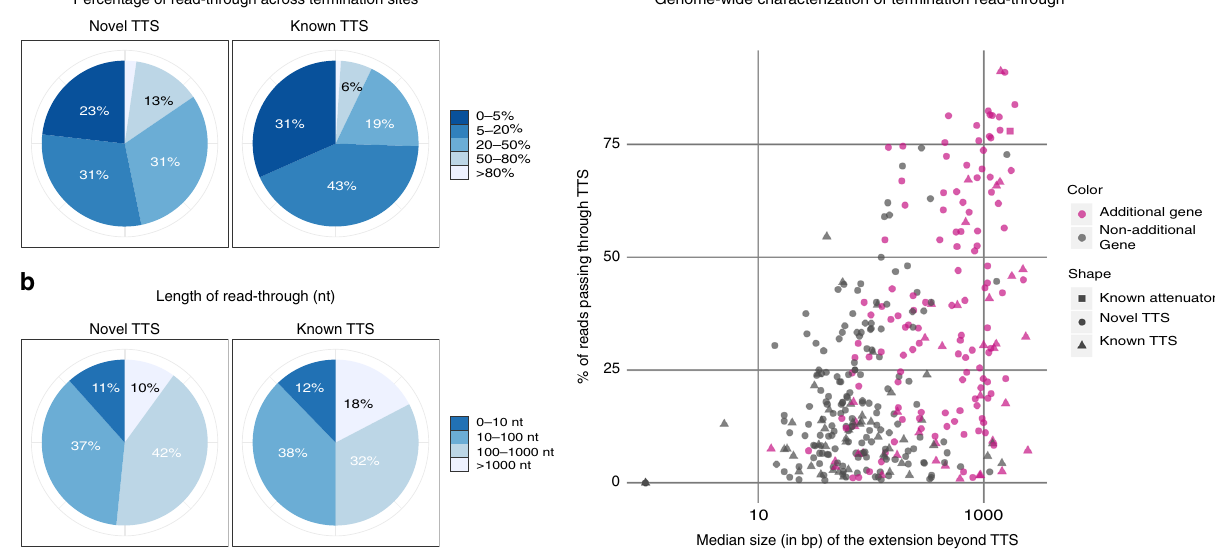
Median size (in bp) of the extension beyond TTS Fig. 4 The vast majority of termination sites have read-through. a Pie chart showing the range of percentage of read-through for novel (left panel) and known (right panel) terminator sites in M9 medium. In 238 out of 310 novel TTS, the read-through is above 5% (Supplementary Data 1). For 67 of the 98 previously known TTS, the read-through is above 5%. b Pie chart showing the range of median size in bp of the 3 ′ extended region passing the termination site in M9 medium. 151 out of 408 termination sites contain additional genes. c Relation between the percentage of read-though ( y -axis) and median size of the region (in bp) located 3 ′ of the TTS ( x -axis) in M9 medium. TTSs with read-through containing additional gene(s) are in